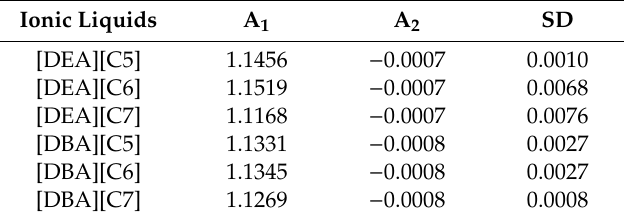
Table 2. Fitting parameters of Equation (1) to correlate density ( ρ ) of synthesized PILs and calculated standard deviation (SD).